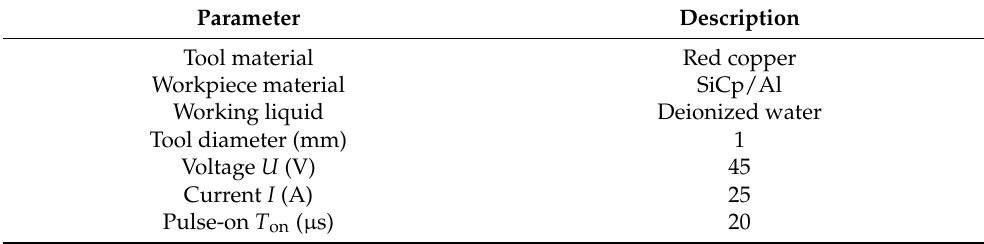
Figure 14. Experimental process of single pulse tip discharge and its schematic diagram. ( a ) Tip discharge with single pulse; ( b ) Tip discharge process. Table 2. Discharge parameters in EDM machining.